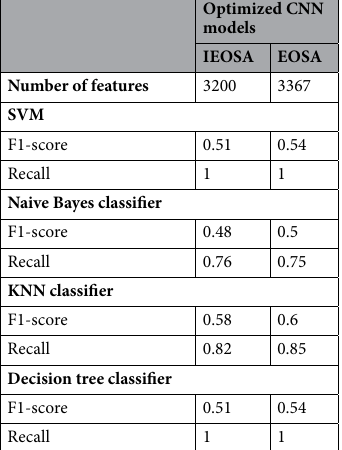
Table 7. Comparative analysis of the number of features selected and classification accuracy, precision, and recall using the IEOSA and its base